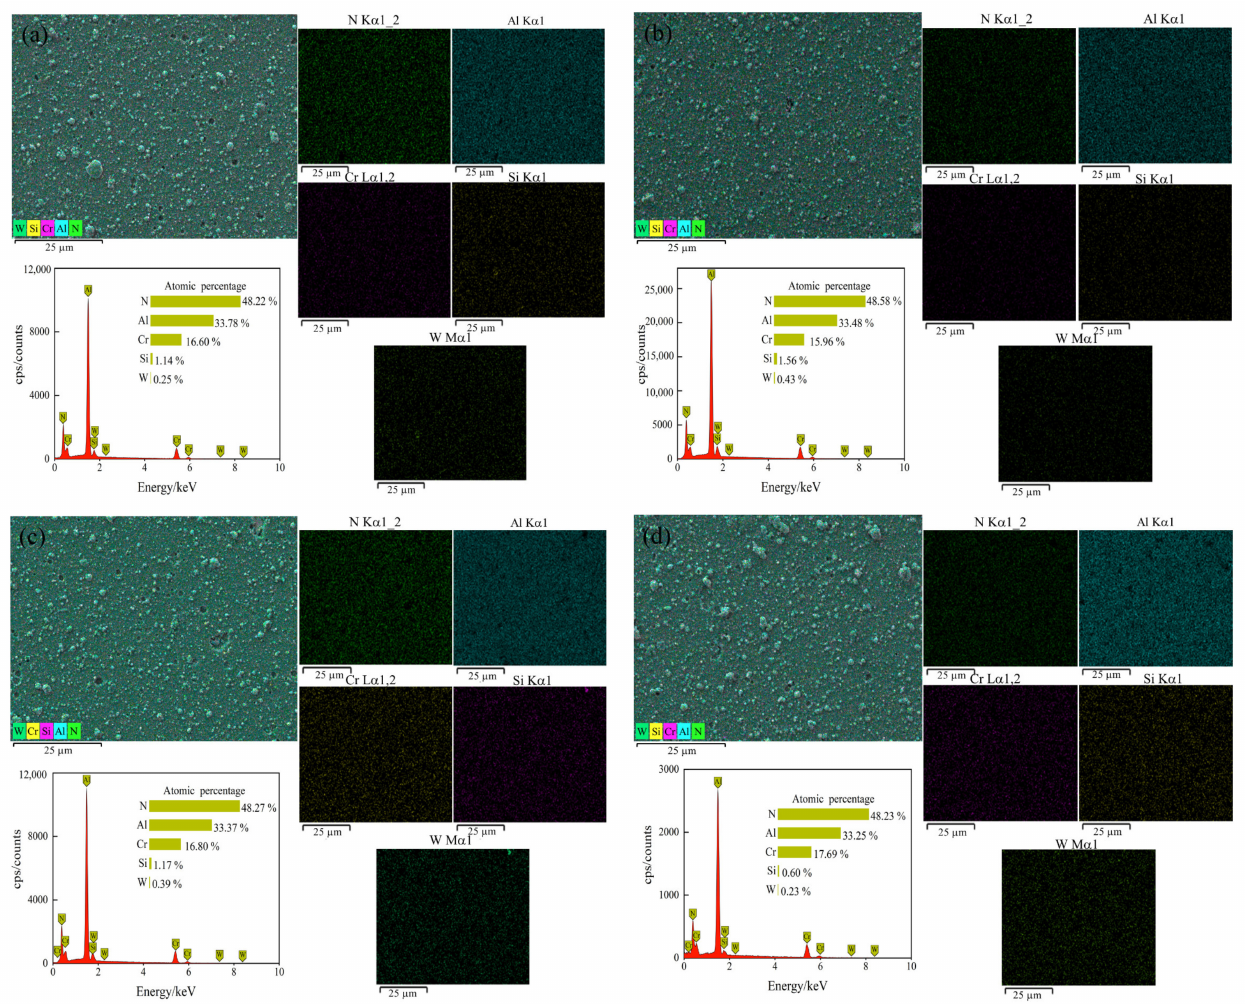
Figure 3. Elemental surface scan profiles for different bias coatings: ( a ) − 60 V; ( b ) − 80 V; ( c ) − 100 V; ( d ) − 120 V. Table 4. Element content of the coating surface with different bias voltages. Bias Voltage/V N/at.% Al/at.% Cr/at.% Si/at.%